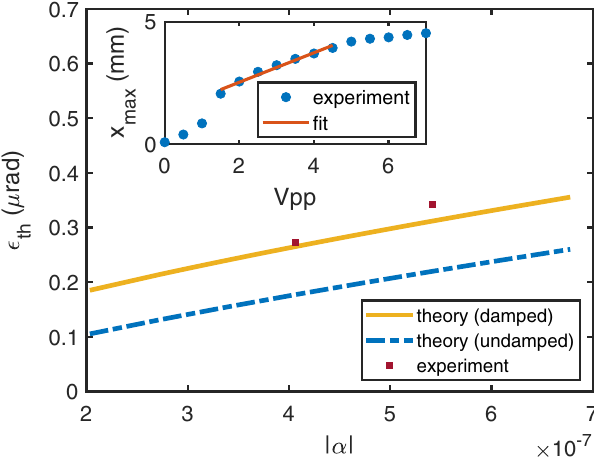
FIG. 7. Comparison of the experimental drive amplitude thresh- old with the theory for the SPEAR3 storage ring for two frequency sweep rates. Inset plot: Maximum beam oscillation amplitude versus waveform generator output voltage for the case with a frequency span of 60